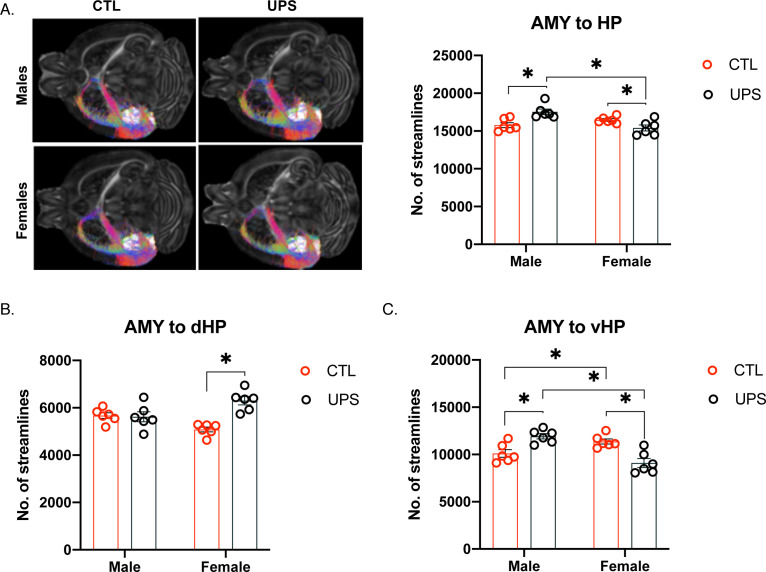
Unpredictable postnatal stress causes sex-specific alterations in AMY–hippocampus connections.(A) Representative images and quantification of the number of streamline connections between AMY and the entire hippocampus. Number of streamline connections between the AMY and the dorsal hippocampus (B) and between the AMY and the vHP (C). AMY – amygdala, dHP – dorsal hippocampus, vHP – ventral hippocampus (n = 6 per rearing and sex group). Mean and SEM, *p<0.05.